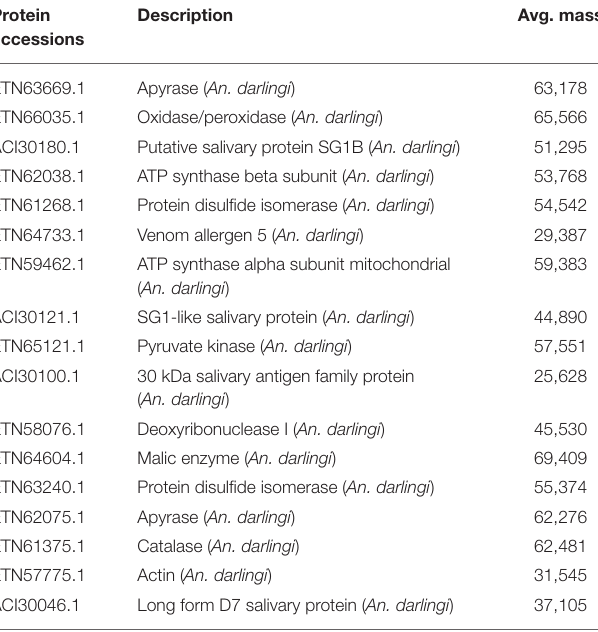
TABLE 2 | List of proteins identified in an ∼ 65 kDa protein band from the western-blot using a pool of serum from study participants.